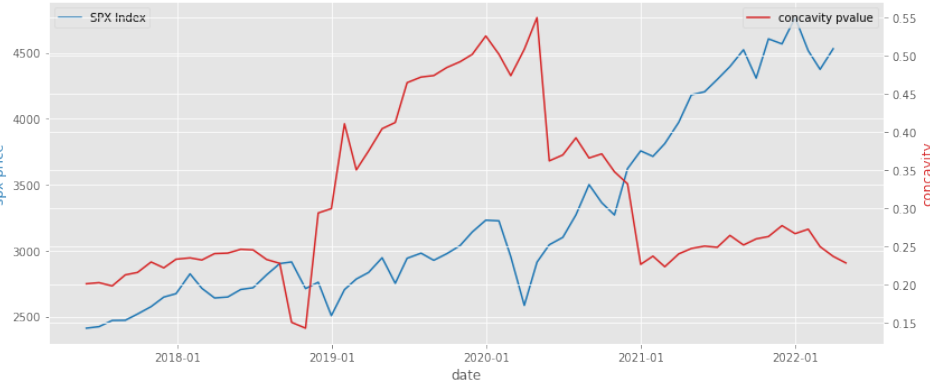
Figure 5. Updated recent 5-year concavity vs. S&P 500 Index (monthly) till the end of March